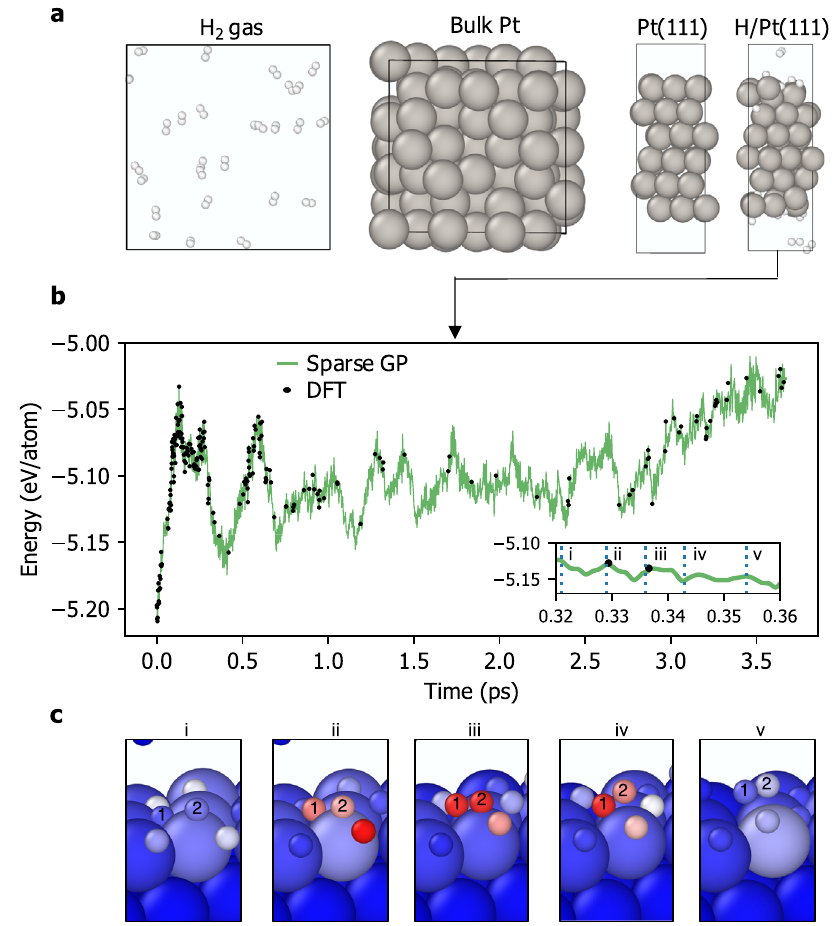
Fig.2|On-the- fl ytrainingofthereactiveSGPforce fi eldforH/Pt.a Snapshotsof four independent training simulations (left to right): gas-phase H 2 ; bulk Pt; (111) facetofthePtsurface;andH 2 interactionwiththePt(111)slab. b Energyversustime duringtheH/Pt(111)trainingsimulation,withtheSGPpredictionsingreenandDFT